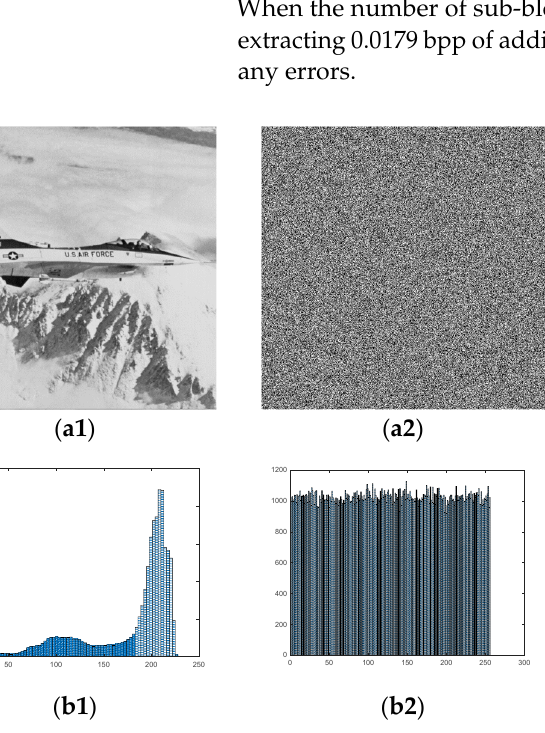
( d4 ) Figure 8. Execution results of our proposed scheme: ( a1 ) The original “Airplane” image with 512 × 512 pixels. ( a2 , a3 ) are the encrypted image and embedded encrypted image (the number of sub-blocks = 8, codebook size = 64, block size = 4 × 4 , and 𝛾 = bpp). ( a4 ) is the decrypted image (PSNR = dB). ( b1 – b4 ) are the corresponding histograms of ( a1 – a4 ). In ( c , d ), the results of “Baboon” (the number of sub-blocks = 4, codebook size = 128, block size = 16 × 16 , 𝛾 = 0.0179 bpp, and PSNR = Inf dB) are given. Additionally, we also analyze the security of our proposed scheme based on infor- mation entropy. The original images, encrypted images, and embedded encrypted images of different block sizes are shown in Table 5. Obviously, the entropy values of the en- crypted image and the embedded encrypted image for each image are all the same, be- cause our proposed scheme only scrambles the encrypted pixel locations. On the other hand, the entropy values of different encrypted images are very close to 8 and are much